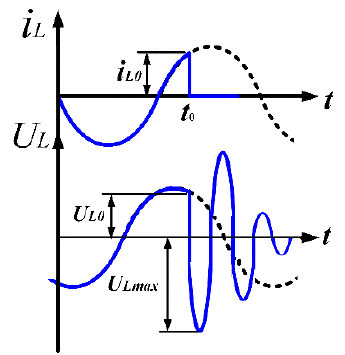
Figure 3. Transformer transient waveform when the pantograph arcing current extinguishes.